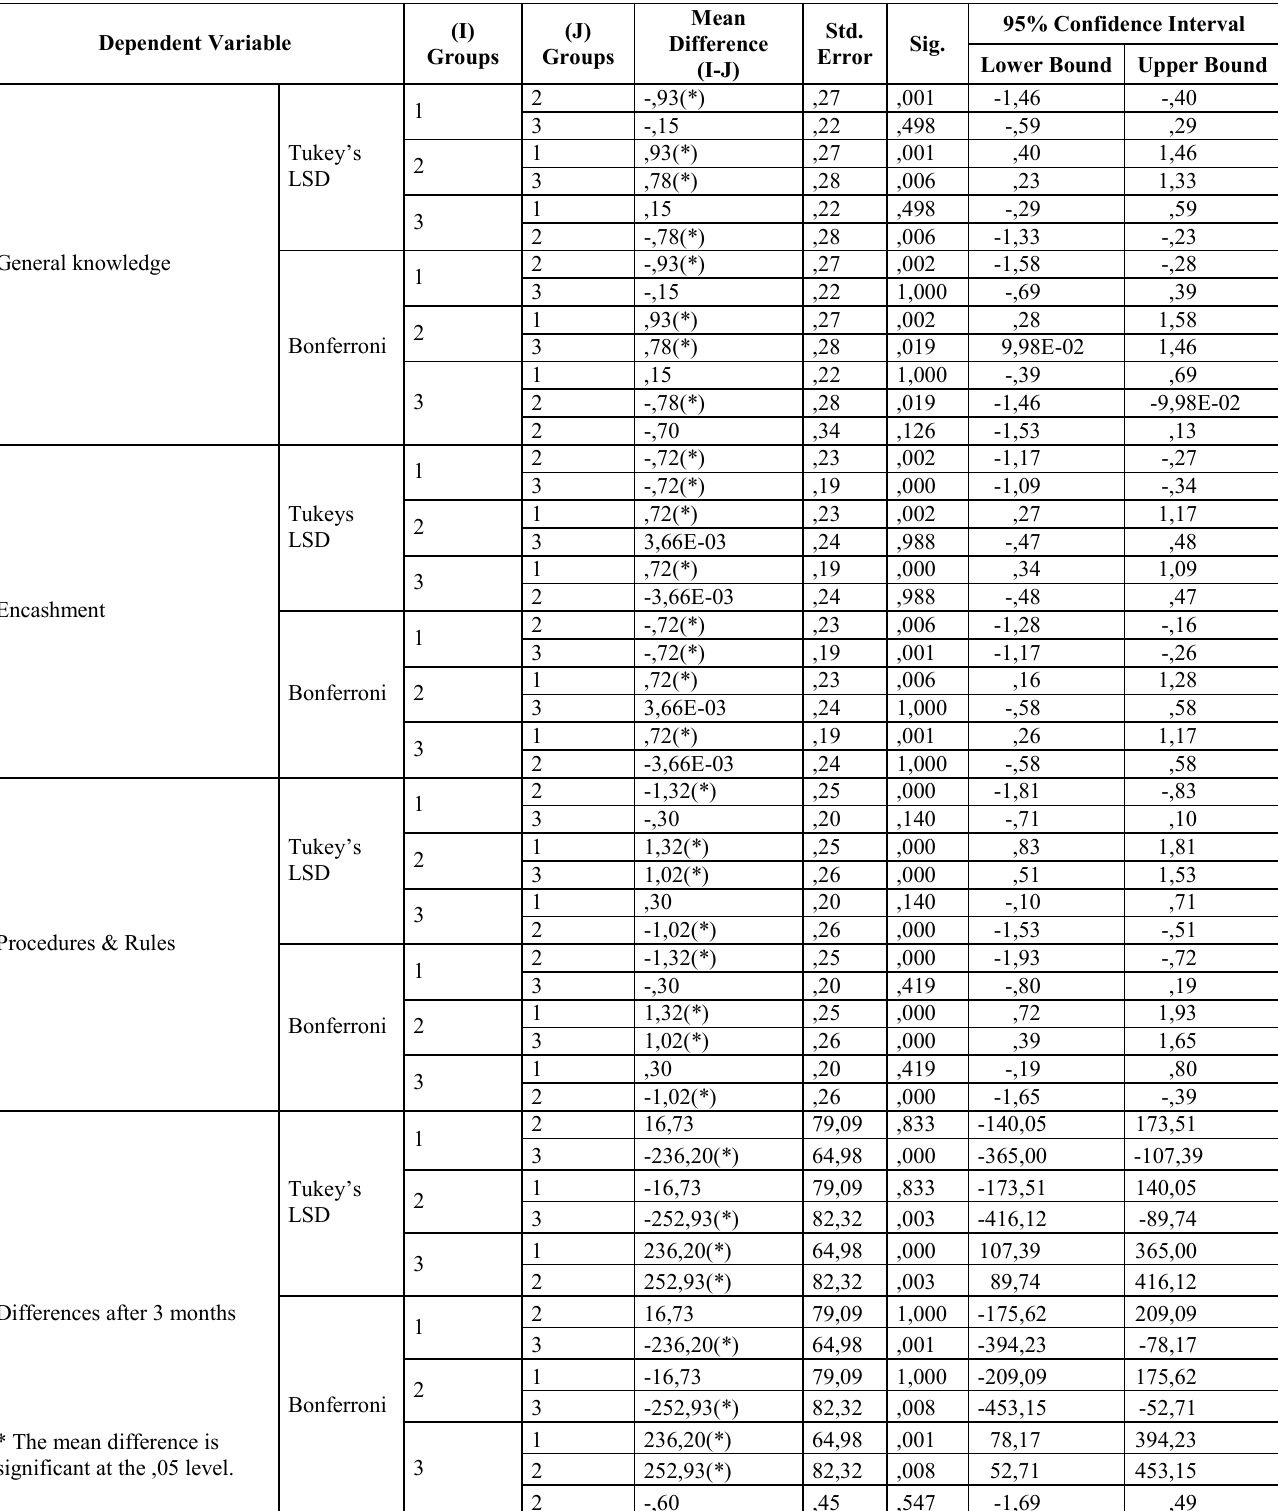
Table 3: Results of the Bonferroni